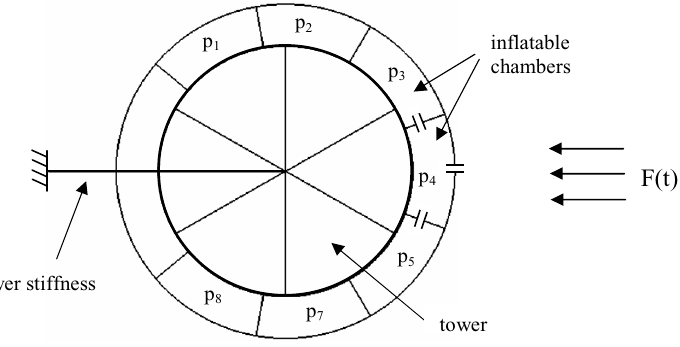
Fig. 2. Horizontal intersection of the inflatable structure for protection of a